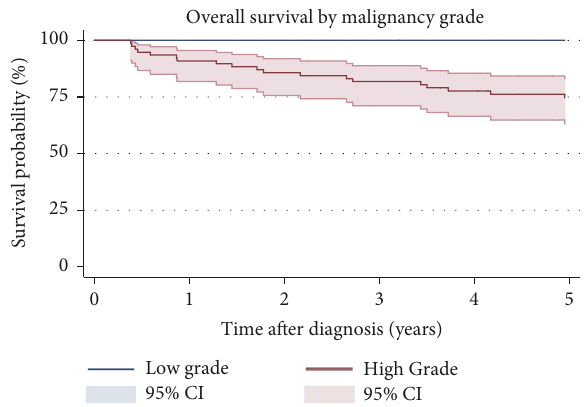
Figure 3: Kaplan-Meier estimates of overall survival by malignancy grade. 95% confidence intervals.